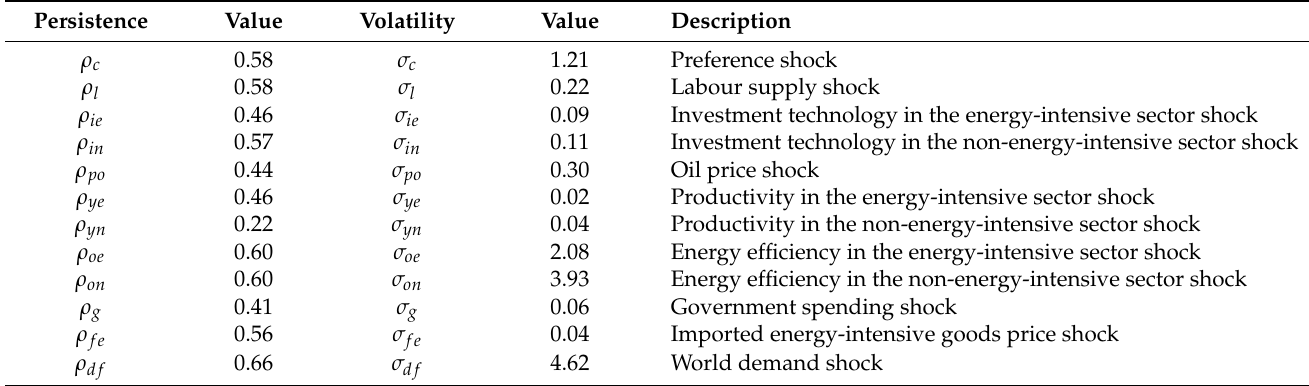
Table 2. Estimates of the shock processes by indirect